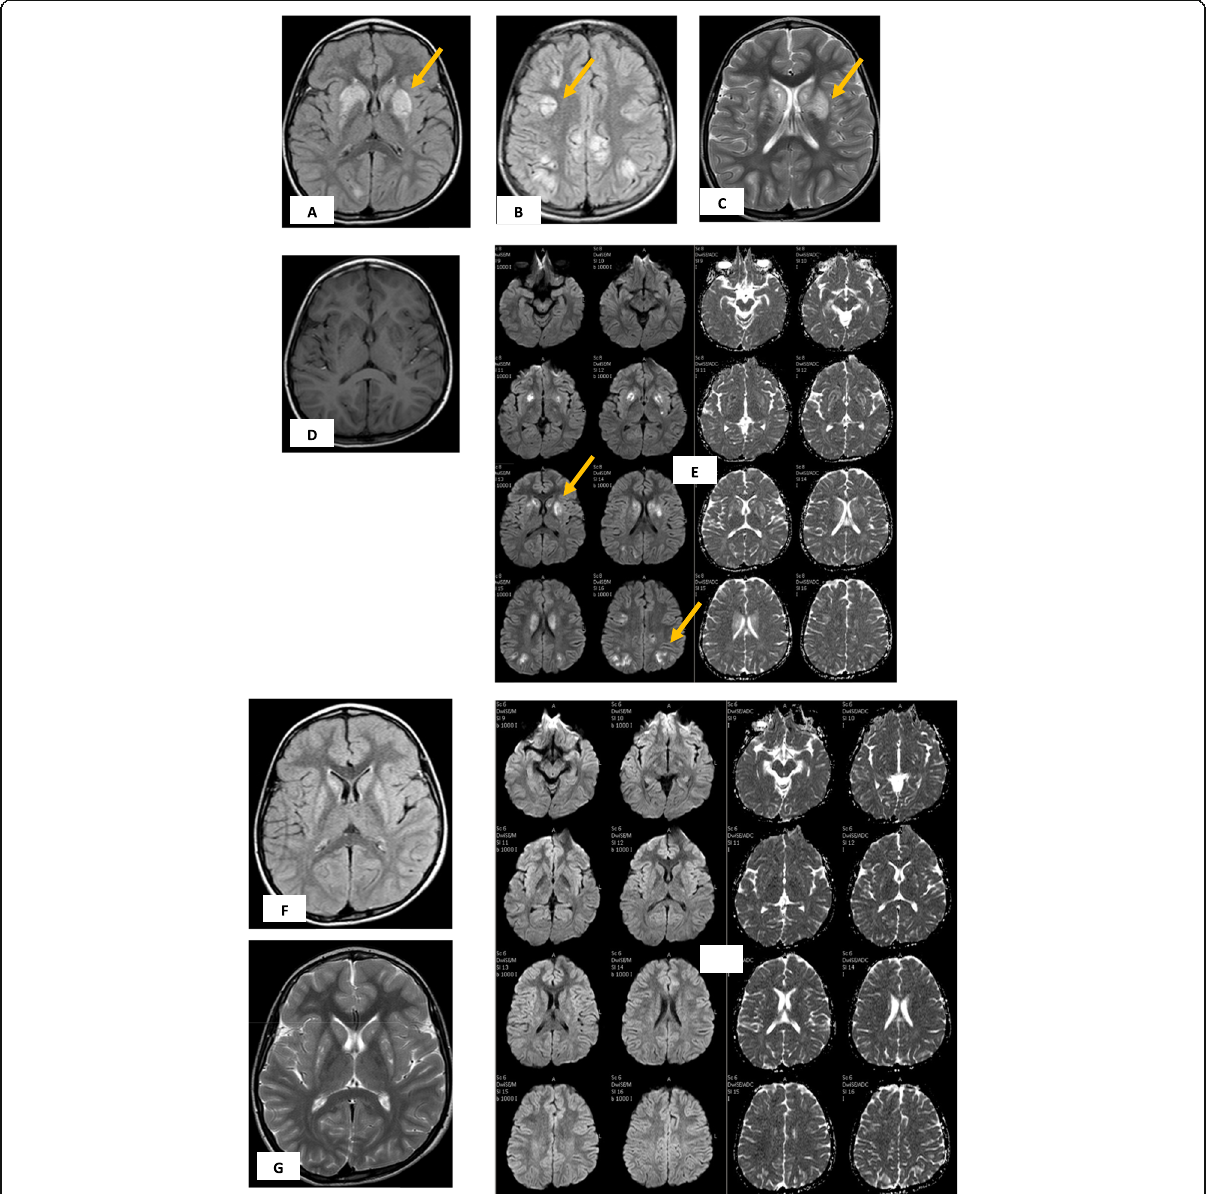
Fig. 5 3-year-old male with BTBGD. Different sequences Initial MRI (March 2018, A-E ) showed bilateral high T2 and FLAIR signal affecting the basal ganglia and thalami as well as the white matter with diffusion restriction (white arrows ) sparing the brain stem and the cerebellum. Follow up MRI ( F,G,H ) at Sept. 2018 after treatment showed complete